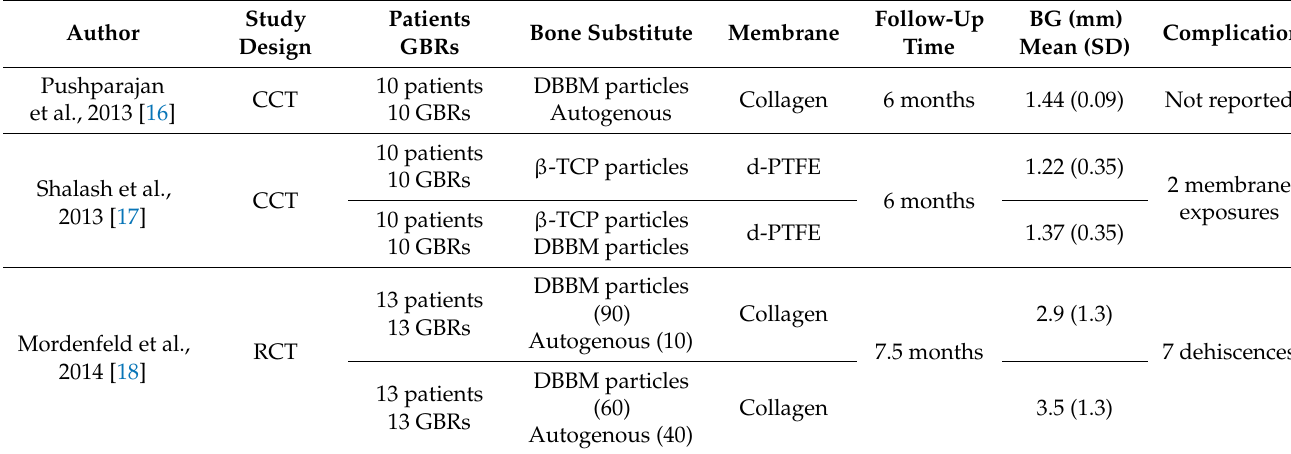
Figure 1. Flow chart of the search results and respective selection process. RCTs: randomized controlled trials, CCTs: cohort and case-control studies, CSs: case series. Table 1. General overview of the included studies, investigating the outcomes of bone defects treated by guided bone regeneration (GBR) with bone graft materials (polymeric membranes and bone graft substitutes as autografts, xenografts, alloplasts, or